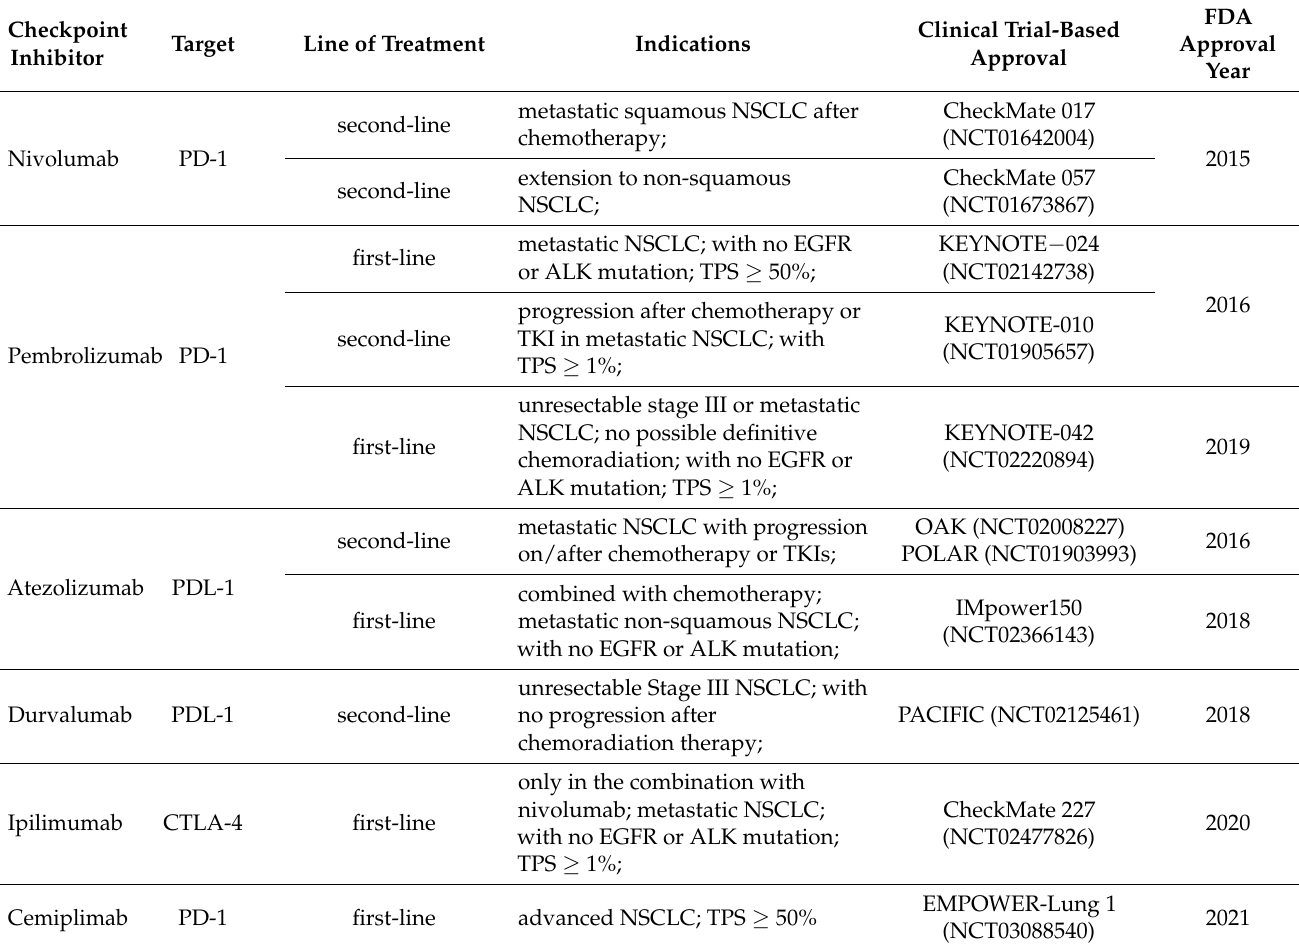
Table 3. FDA-approved immunotherapy drugs for the treatment of